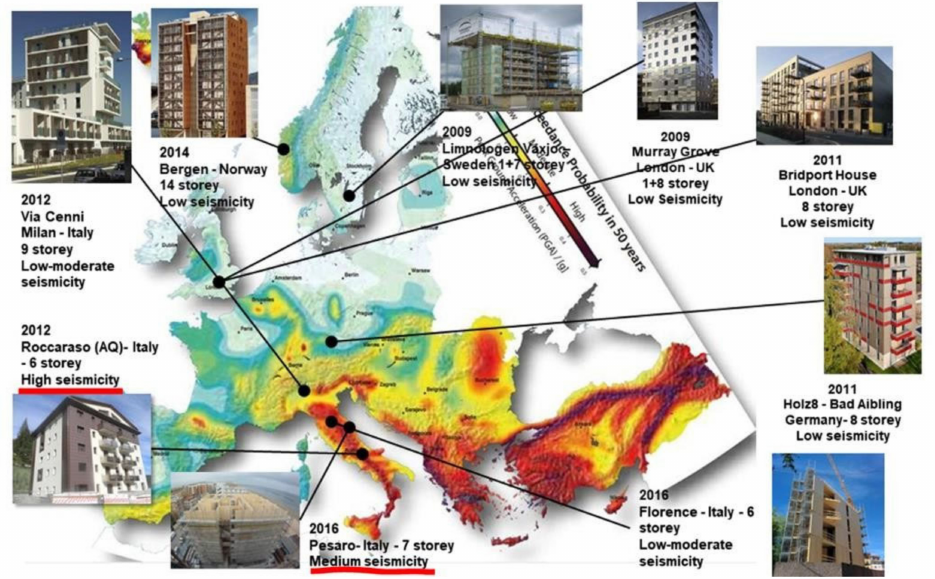
Figure 1. Multi-storey timber buildings built in the last fifteen years in European areas with different seismicity